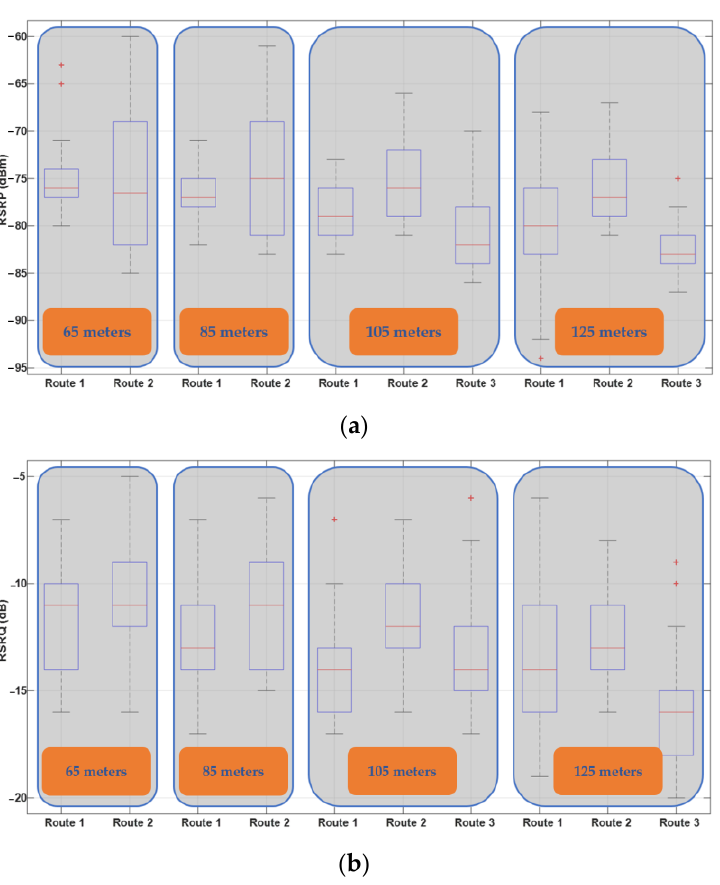
Figure 19. Statistical results of the conducted aerial drive test on the UKM campus at different routes and flight heights: ( a ) RSRP and ( b ) RSRQ.